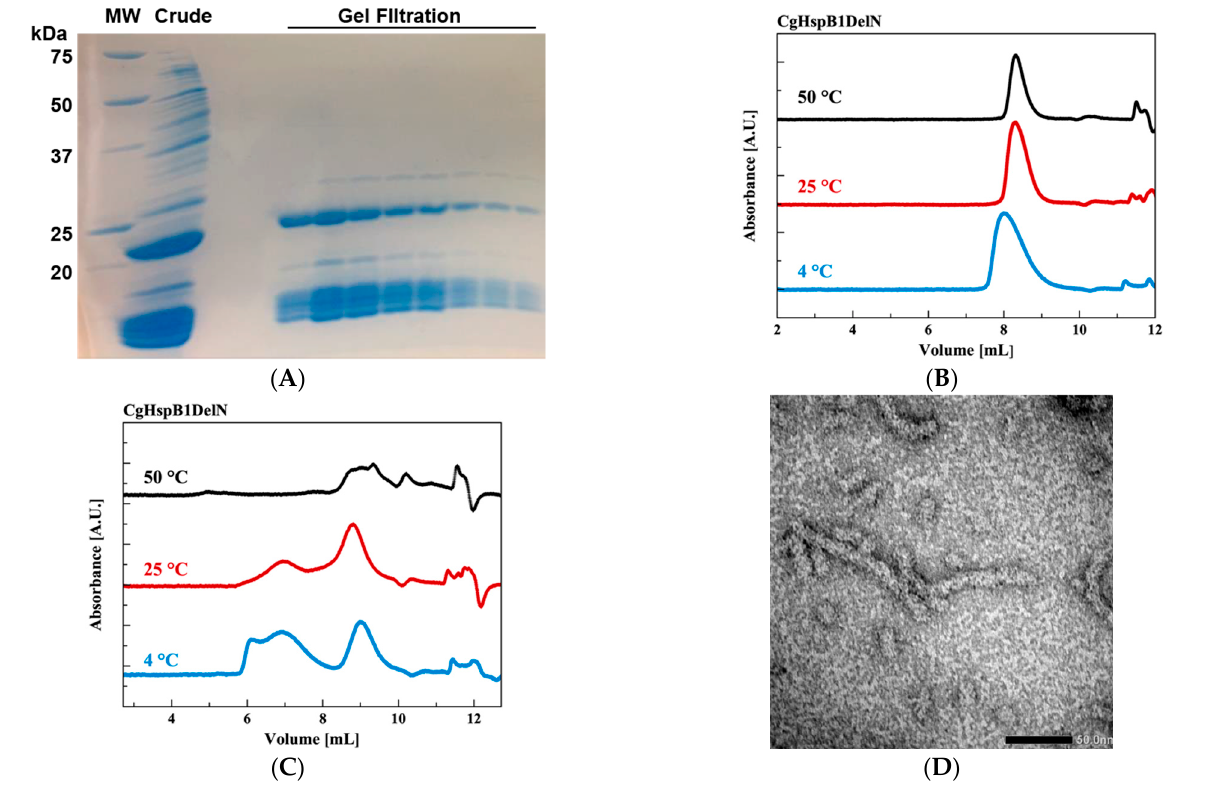
Figure 6. Characterization of CgHspB1DelN and CgHspB1DelC. ( A ) SDS–PAGE of CgHspB1DelN. MW—molecular weight marker, Crude—collected fractions of 1-st anion exchange chromatography, Gel-filtration—fractions of gel filtration chromatography. ( B ) HPLC-SEC analysis of CgHspB1DelN. ( C ) HPLC-SEC analysis of CgHspB1DelC. ( D ) Electron microscopy image of CgHspB1DelC.